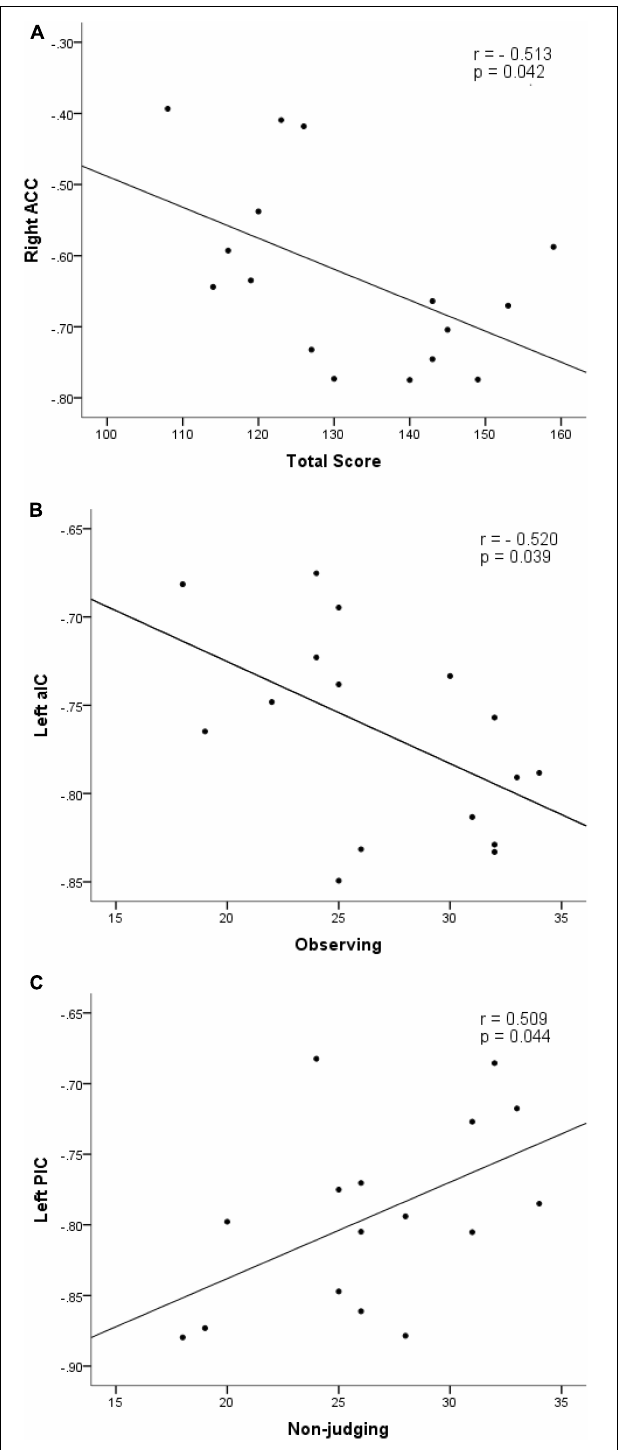
FIGURE 3 | Scatter plot diagrams. The plots and fitted lines indicate: inverse correlations between the ALFF values of ROIs in right anterior cingulate cortex and aIC.L cortex with the total score ( r = –0.513, p = 0.042) (A) and observing score ( r = –0.520, p = 0.0392) (B) ; a positive correlation between the ALFF value of posterior insula (pIC) and non-judgment score ( r = 0.509, p = 0.044) (C) of